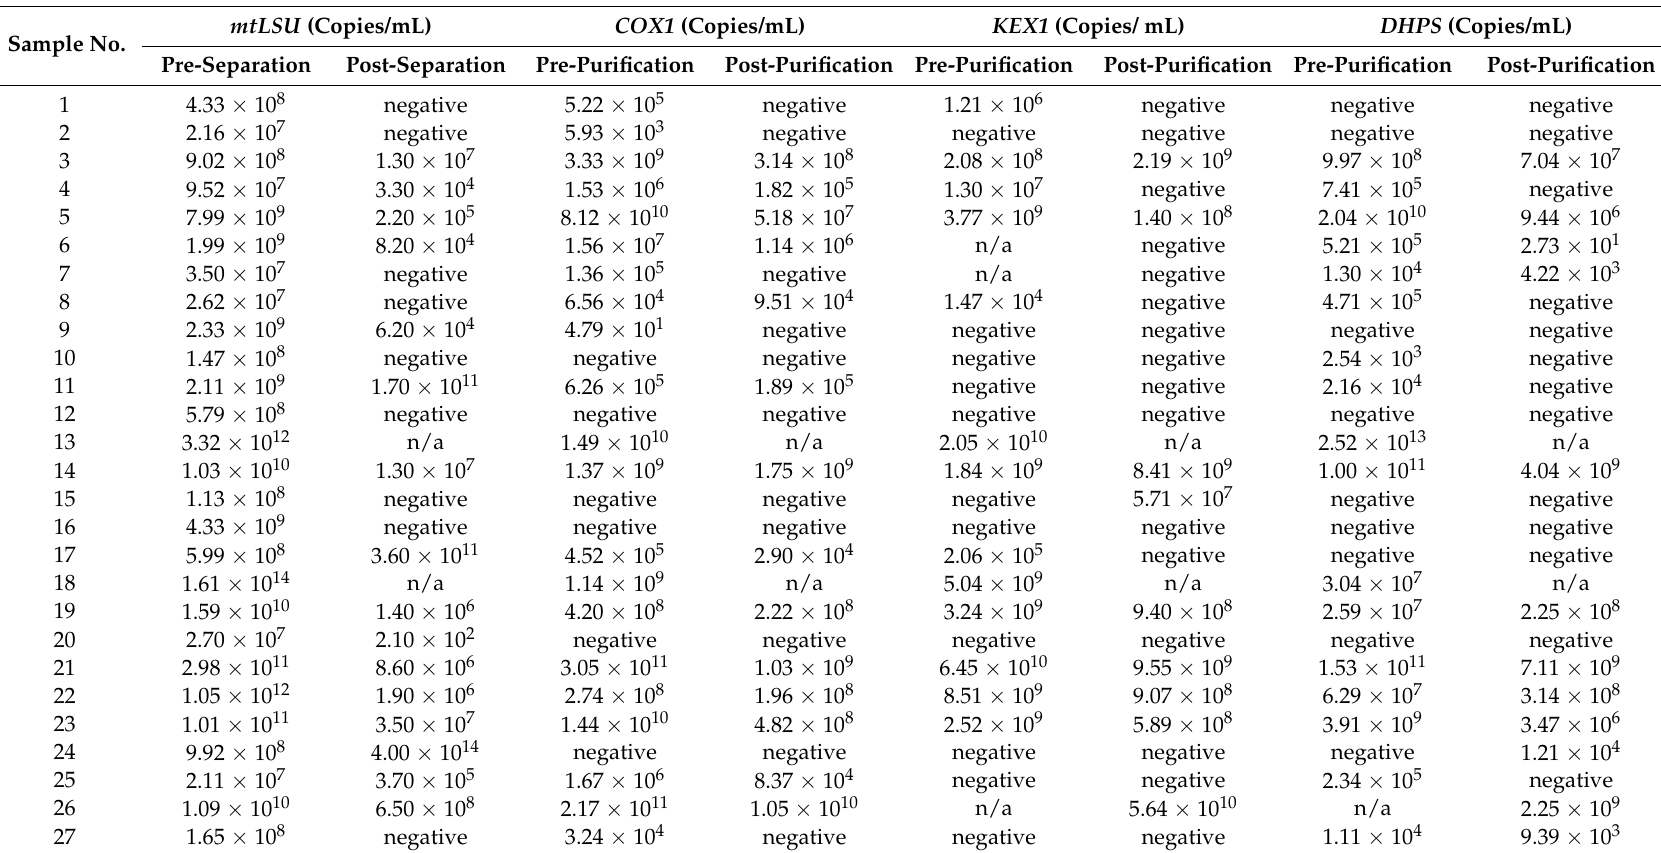
Table A1. Results of qPCRs for nuclear and mitochondrial gene copy number. Results of qPCRs for nuclear and mitochondrial gene copy numbers in 34 BALF samples with high titer of mtLSU gene copies ( ≥ 1 × 10 7 mtLSU copies/mL) before and after MACS purification of P. jirovecii particles. In case of samples 13, 18, 28, 29 and 31 no material was left for magnetic separation. After MACS purification of P. jirovecii particles three samples showed a positive fungal proof and two samples showed a positive bacterial proof in the respective endpoint PCRs. n/a not applicable.